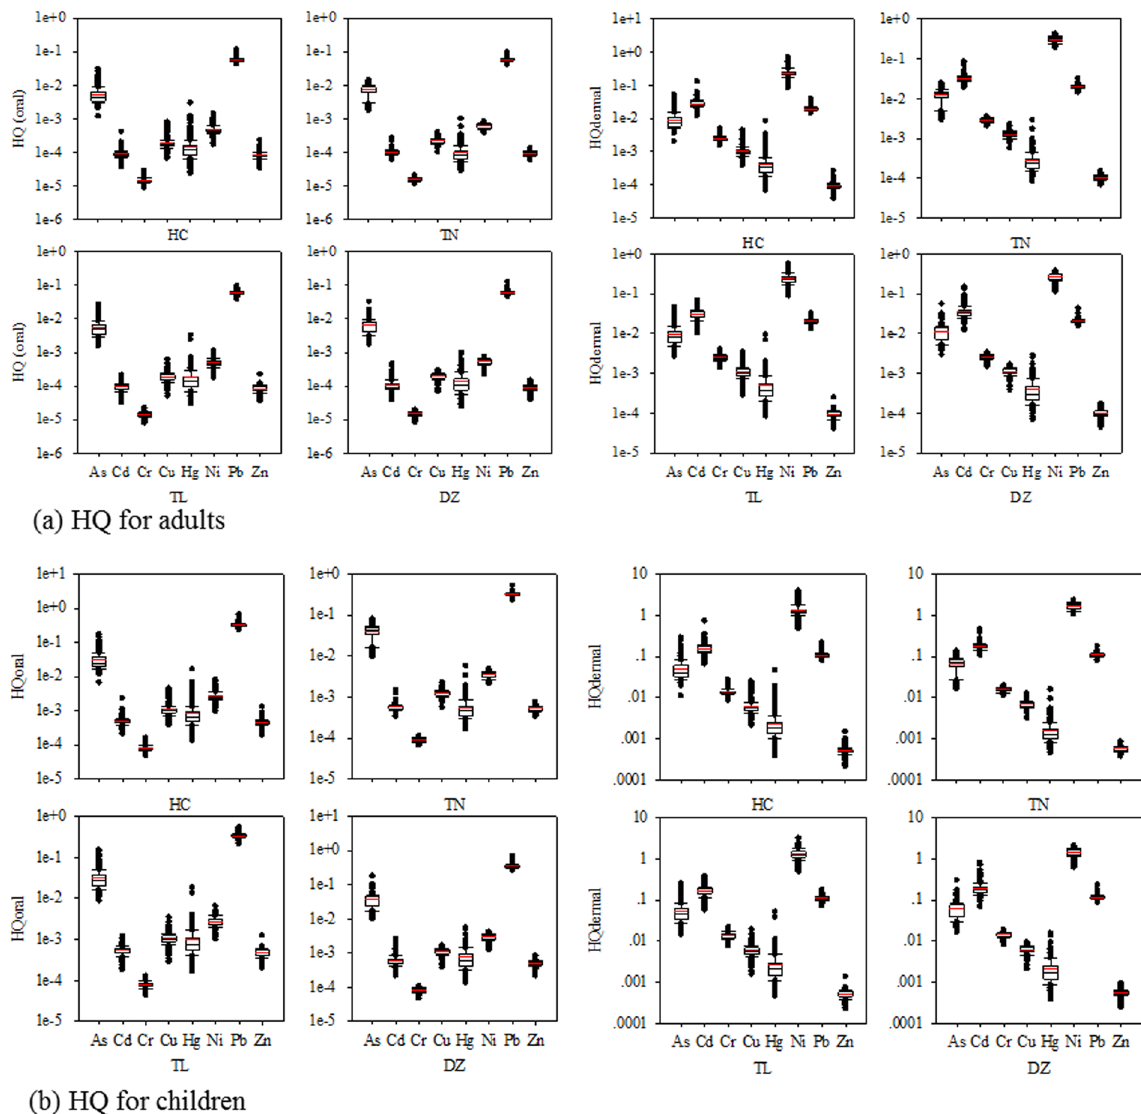
Figure 4. HQ oral (the sum of ingestion and inhalation) and HQ dermal for adults ( a ) children ( b ) exposure to HMS in soils of each County (symbols for boxplot are similar to Fig.